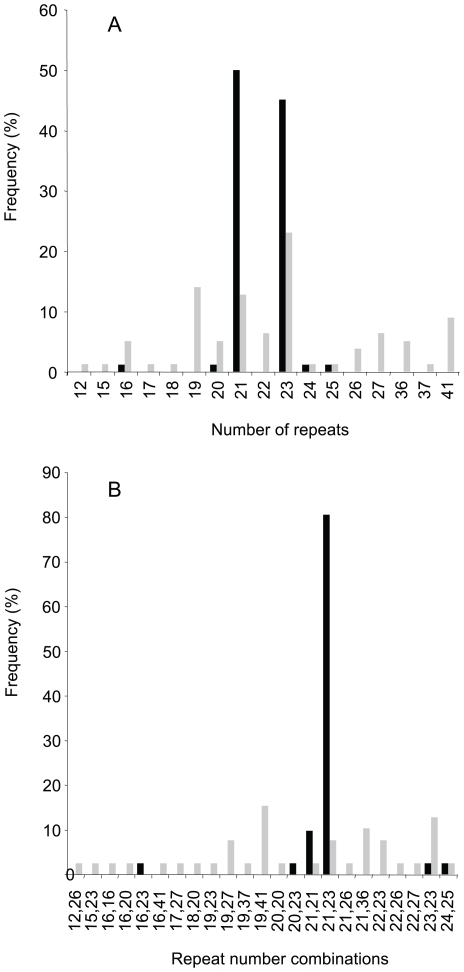
Frequencies of repeat regions of different lengths and frequencies of repeat region combinations.Frequencies (B) among GPG clinical isolates are indicated by black bars, frequencies among other clinical isolates by grey bars. Lengths (A) are expressed as numbers of 4 amino acid repeat units. One borderline GPG strain and one borderline non-GPG strain (see Table 1) were included in the analysis.